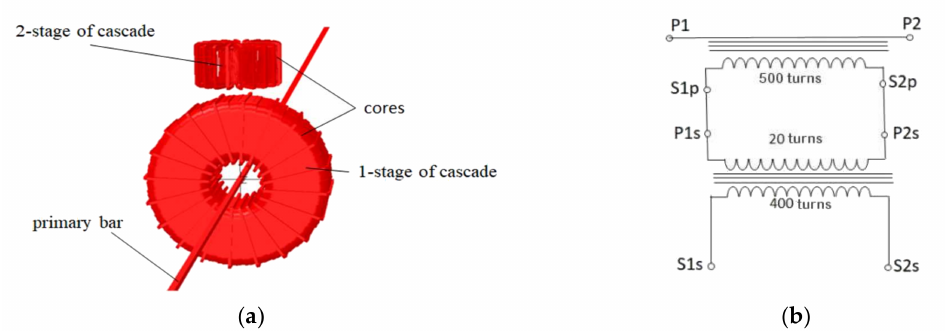
Figure 1. A 3D geometrical model of the 2-stage cascade current transformer for measuring short- circuit currents 50 kA/5 A ( a ) and its equivalent electric circuit ( b ), where P1, P2—primary bar terminals, S1p, S2p—terminals of secondary winding the first stage of cascade, P1s, P2s—terminals of primary winding the second stage of cascade, S1s, S2s—terminals of secondary winding the second stage of